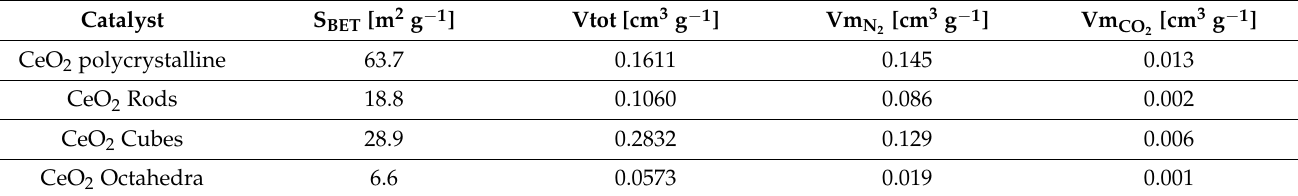
Table 1. Textural properties of cerium oxide shapes.